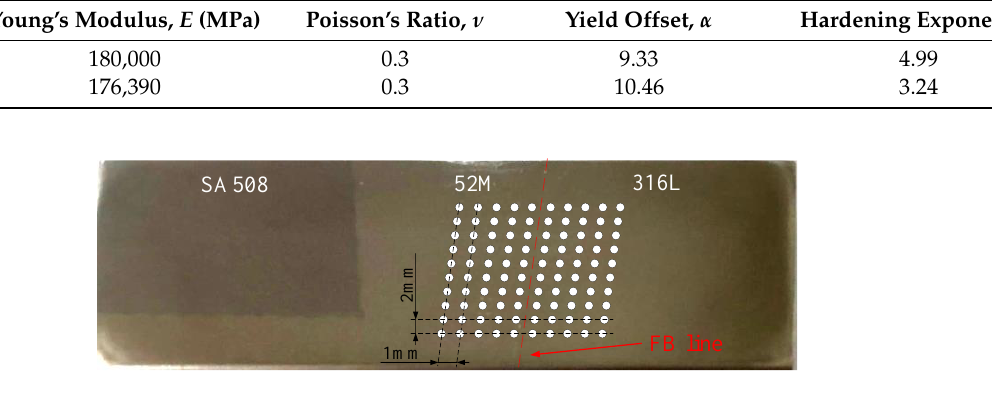
Table 1. Mechanical property of the material [16,17].